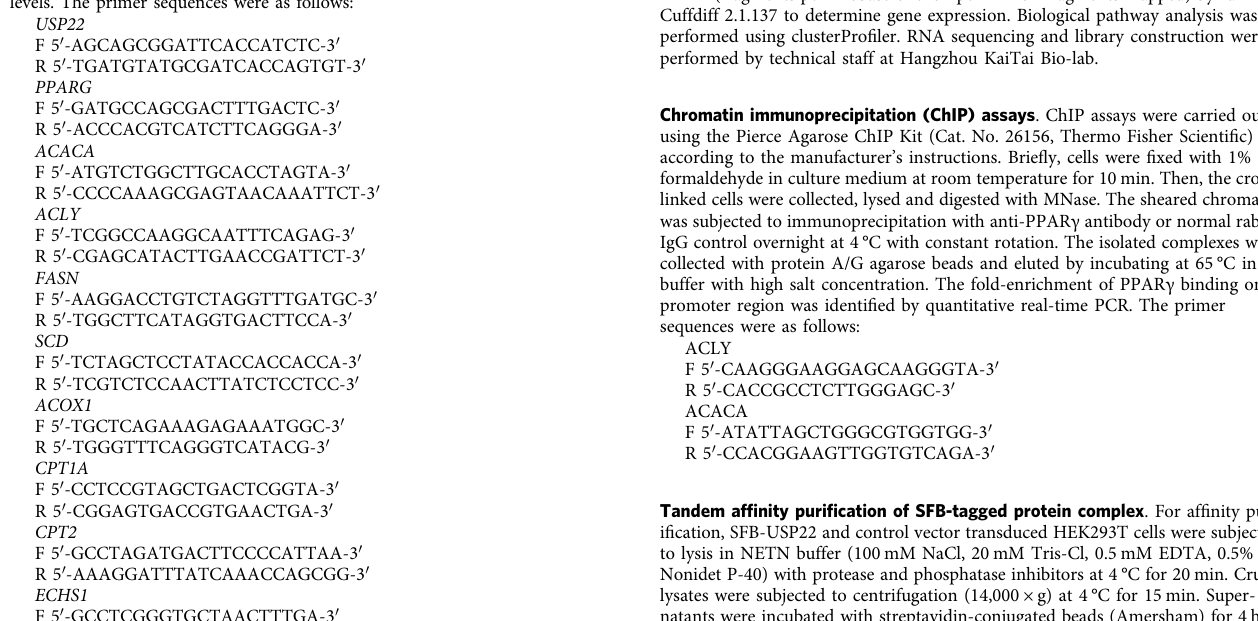
Fig. 7 USP22-driven de novo synthesis participates in HCC tumorigenesis through ACC and ACLY upregulation by PPAR γ . a , b The percentages of various isotopomers of FA 16:0 after trace to [U- 13 C] glucose in MHCC-97L-related stable cells (Control, USP22, USP22 + shACC and USP22 + shPPAR γ ) ( a ) and MHCC-97H-related stable cells (shControl, shUSP22-1 and shUSP22-1 + PPAR γ ) ( b ). Medium was changed to RPMI 1640 containing [U- 13 C] glucose (2 g/L) when cell con fl uence reached 80%, and 24 h later cells were washed with cold PBS and snap-frozen in liquid nitrogen and subjected to LC-MS analysis. n = 4 biologically independent experiments. c , d The relative content of TG was analyzed in above cell lines from a ( c ) and b ( d ). The data shown represent the means (±SD) of biological triplicates. Cells were analyzed after 24 h adherence. n = 4 ( c ) or n = 5 ( d ) biologically independent experiments. e , f Oil red staining assay in above cell lines from a ( e ) and b ( f ). Cells were analyzed after 24 h adherence. Scale bars, 100 μ m. g − i MHCC-